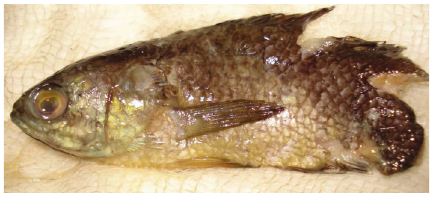
Figure 2: Fish after